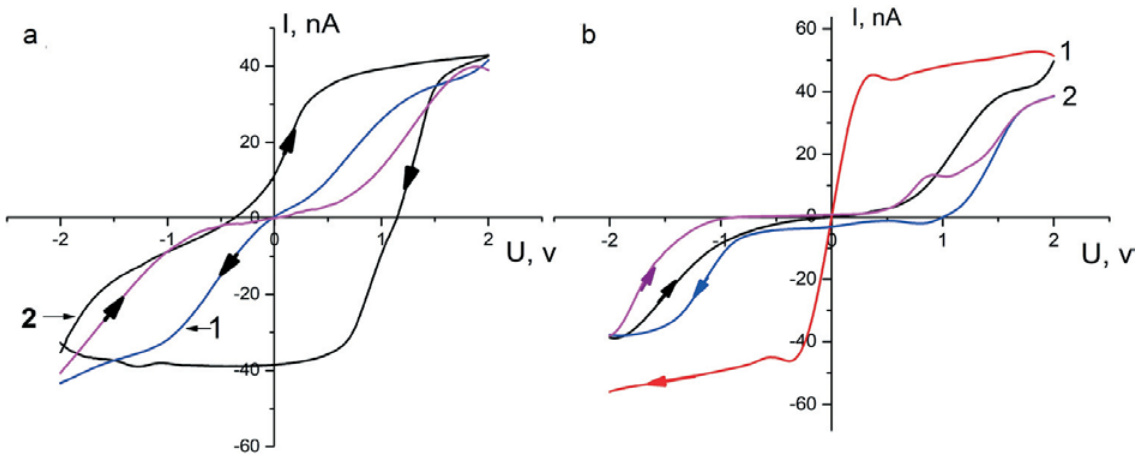
Fig. 5 . LTCVCs of DPT-0 (1) and DPT-1 (2) on the surfaces of gold (a) and graphite